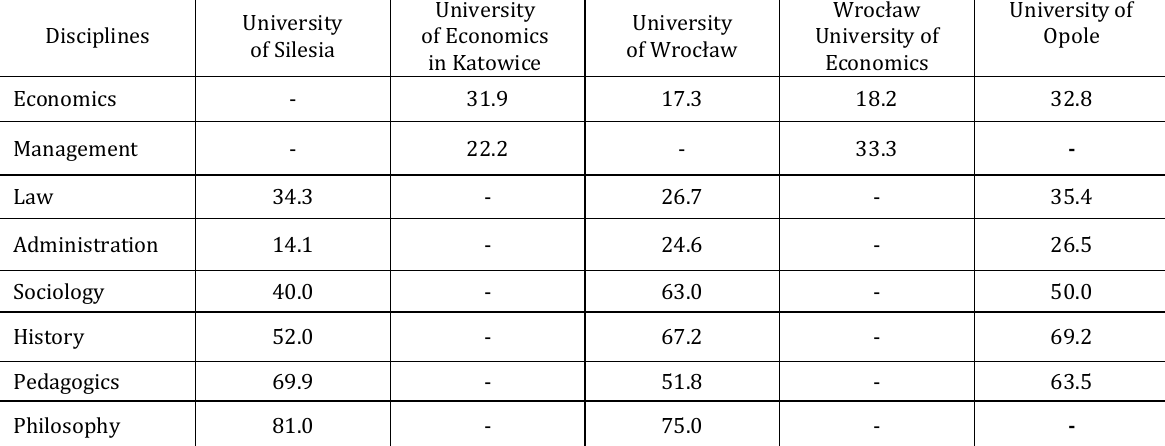
Table. 4. Share of interests (%) as the main reason for undertaking studies HEI (Source: own compilation)